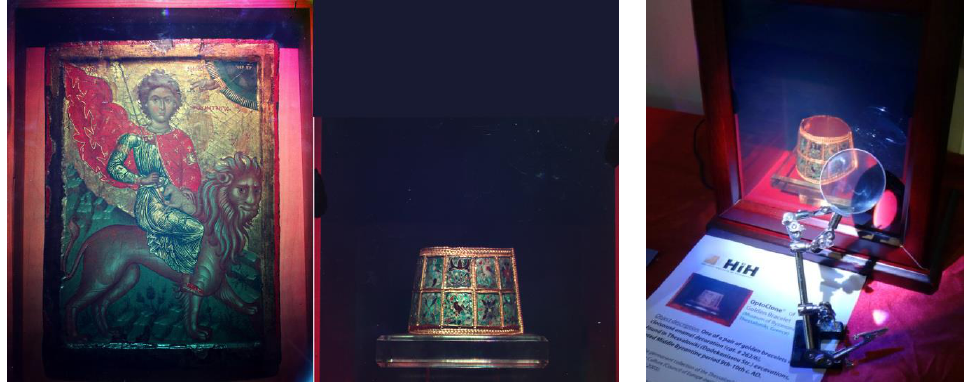
Figure 9. Left : Photograph of the OptoClone TM of the Saint Mamas icon (© 2013 HiH). Center and Right : Two views of the same OptoClone TM of one of a pair of bracelets MBC cat. BKO262/6, 10th c. AD (© 2013 HiH).